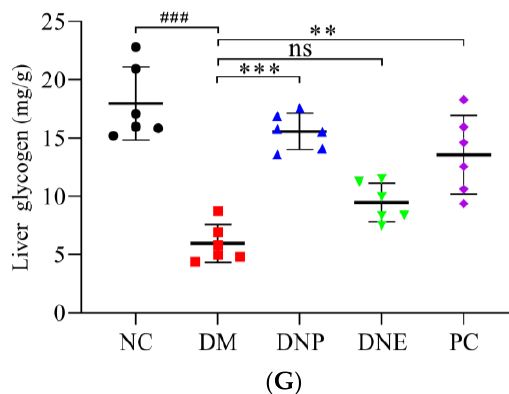
Figure 13. Effects of D. nobile on serum lipid profile, insulin level and liver glycogen (( A ): TC, ( B ): TG, ( C ): LDL-C, ( D ): HDL-C, ( E ): FINS, ( F ): HOMA-IR and ( G ): liver glycogen) contents of T2DM rats. All data are expressed as mean ± S.D. (n = 6 per group). Compared with the NC group, ### p < 0.001; compared with the DM group, ** p < 0.01 and *** p < 0.001.